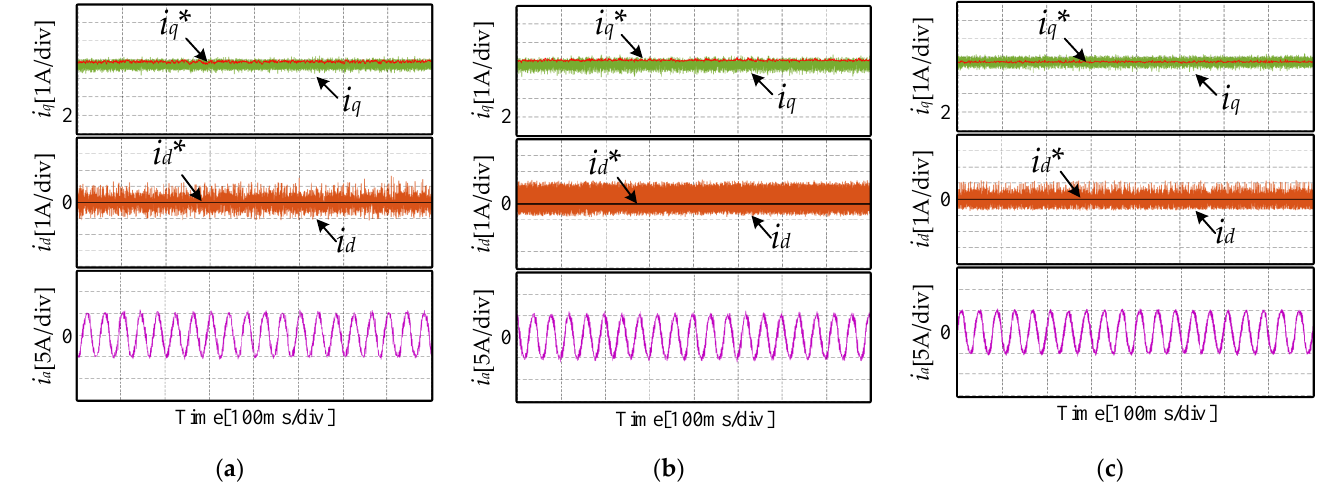
Figure 6. Experimental results of dq − axis current and phase current under matched motor param- eters: ( a ) MPCC; ( b ) CMFPCC; ( c ) IMFPCC. The comparison of the three subplots in Figure 6a–c shows that the steady − state current ripple of the MPCC strategy and the proposed IMFPCC strategy are similar when the motor parameters are matched. The steady − state current ripple of the CMFPCC strategy is the largest. The phase current FFT analysis in Figure 7 shows the current THD of 17.89% and 16.52% for the two, respectively. It proves that the three − phase current ripple of the CMFPCC strategy based on the classical ultra − local structure is significantly higher than that of the IMFPCC strategy based on the optimized ultra − local structure, and its phase current THD is as high as 19.13%.